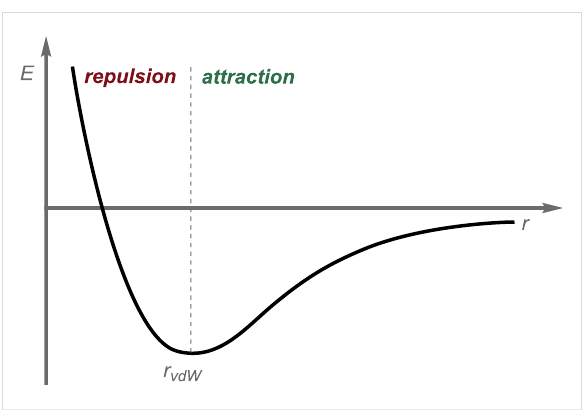
Figure 1: Dispersion = attractive part of the van-der-Waals